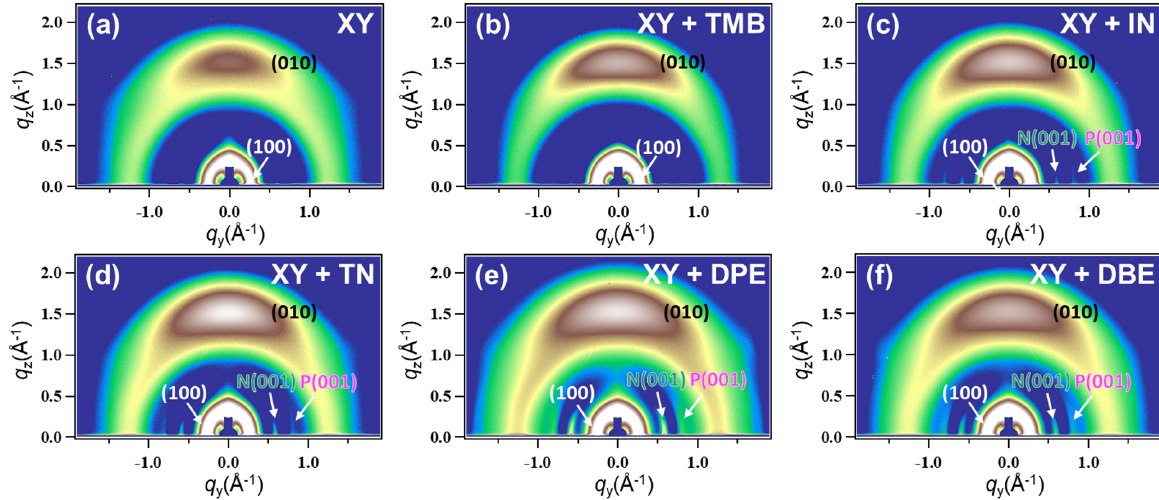
Figure 8. GIXD images of ( a ) XY ‐ , ( b ) XY + TMB ‐ , ( c ) XY + IN ‐ , ( d ) XY + TN ‐ , ( e ) XY + DPE ‐ , and ( f ) XY + DBE ‐ based blend films. The (100) and (010) peaks consist of both p ‐ and n ‐ type polymers; N(001) corresponds to the (001) peak of n ‐ type polymer and P(001) corresponds to the (001) peak of p ‐ type polymer. p -type